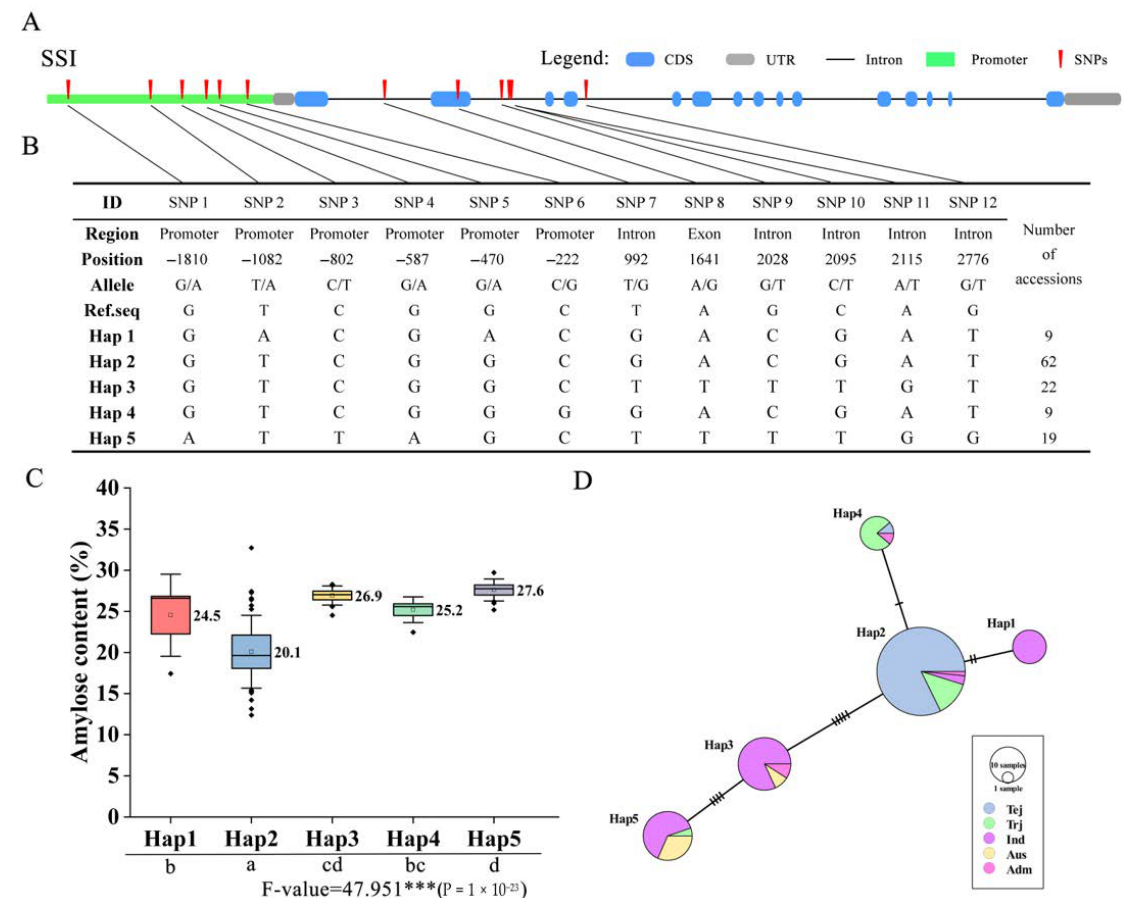
Figure 6. Haplotype analysis of OsSSI . ( A ) Structural representation of OsSSI and upstream promoter region. ( B ) OsSSI SNPs and haplotype groups in 137 rice accessions. SNP positions are given relative to the start of the 5 (cid:48) UTR. Hap: haplotype. ( C ) Association of phenotype with haplotype. Different letters indicate significant AC differences between haplotypes (ANOVA, Duncan test). ( D ) Haplotype network variation of OsSSI . The circle size represents the number of accessions in each Hap, and the number of transverse lines between each Hap represents the number of nucleotide variations. Tej: Temperate japonica ; Trj: Tropical japonica ; Ind: Indica ; Aus: Aus ; and Adm: Admixture rice